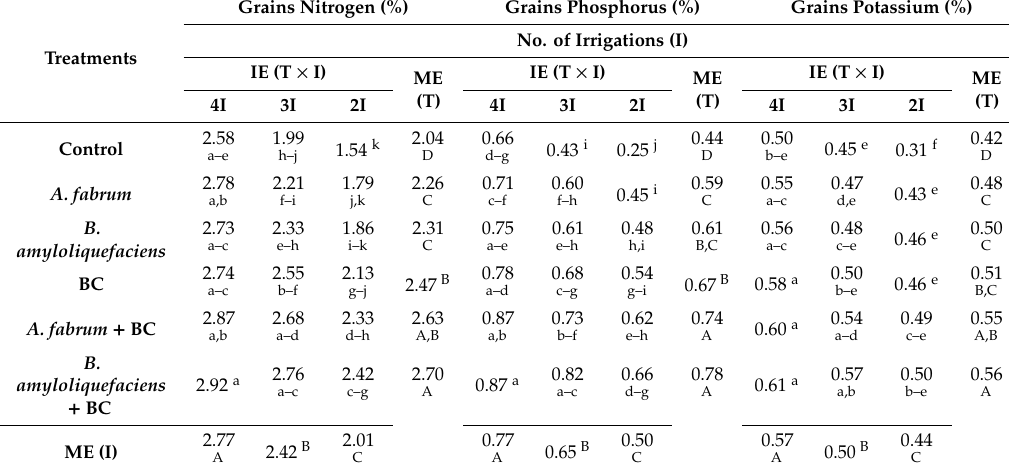
Table 4. E ff ect of Agrobacterium fabrum , Bacillus amyloliquefaciens with / without biochar (30 Mg ha − 1 ) on nitrogen, phosphorus and potassium concentration in wheat grain cultivated in drought-stressed field conditions